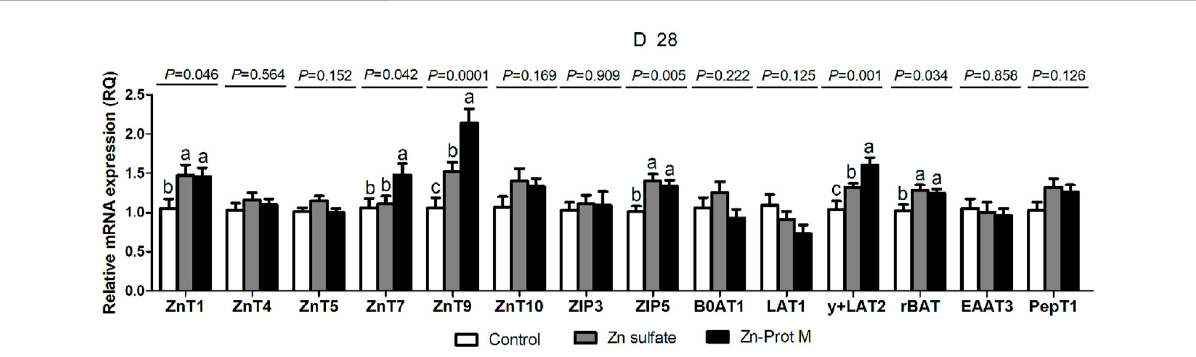
FIGURE 1 Effect of dietary Zn source on the mRNA expression levels of Zn, amino acid, and small peptide transporters in the duodenum of broilers at 28 daysofage.Valuesaremeans±SE,( n =7/8).Lackingthesameletters(a,b,andc)meanssigni fi cantdifferences, p < 0.05.ZnT1,zinctransporter1; ZnT4, zinc transporter 4; ZnT5, zinc transporter 5; ZnT7, zinc transporter 7; ZnT9, zinc transporter 9; ZIP3, Zrt-irt-like protein 3; ZIP5, Zrt-irt-like protein 5; B0AT1, B-0-system neutral amino acid co-transporter; LAT1, L-type amino acid transporter 1; y + LAT2, y + L-type amino acid transporter 2; rBAT, b0,+-type amino acid transporter; EAAT3, excitatory amino acid transporter 3; PepT1, peptide-transporter 1; Zn-Prot M, Zn proteinate with moderate chelation strength (Q f = 51.6). The mRNA expression levels were calculated as the relative quantities (RQs) of the target gene mRNA to the geometric mean of β -actin and GAPDH mRNA using the 2 − ΔΔ CT method.